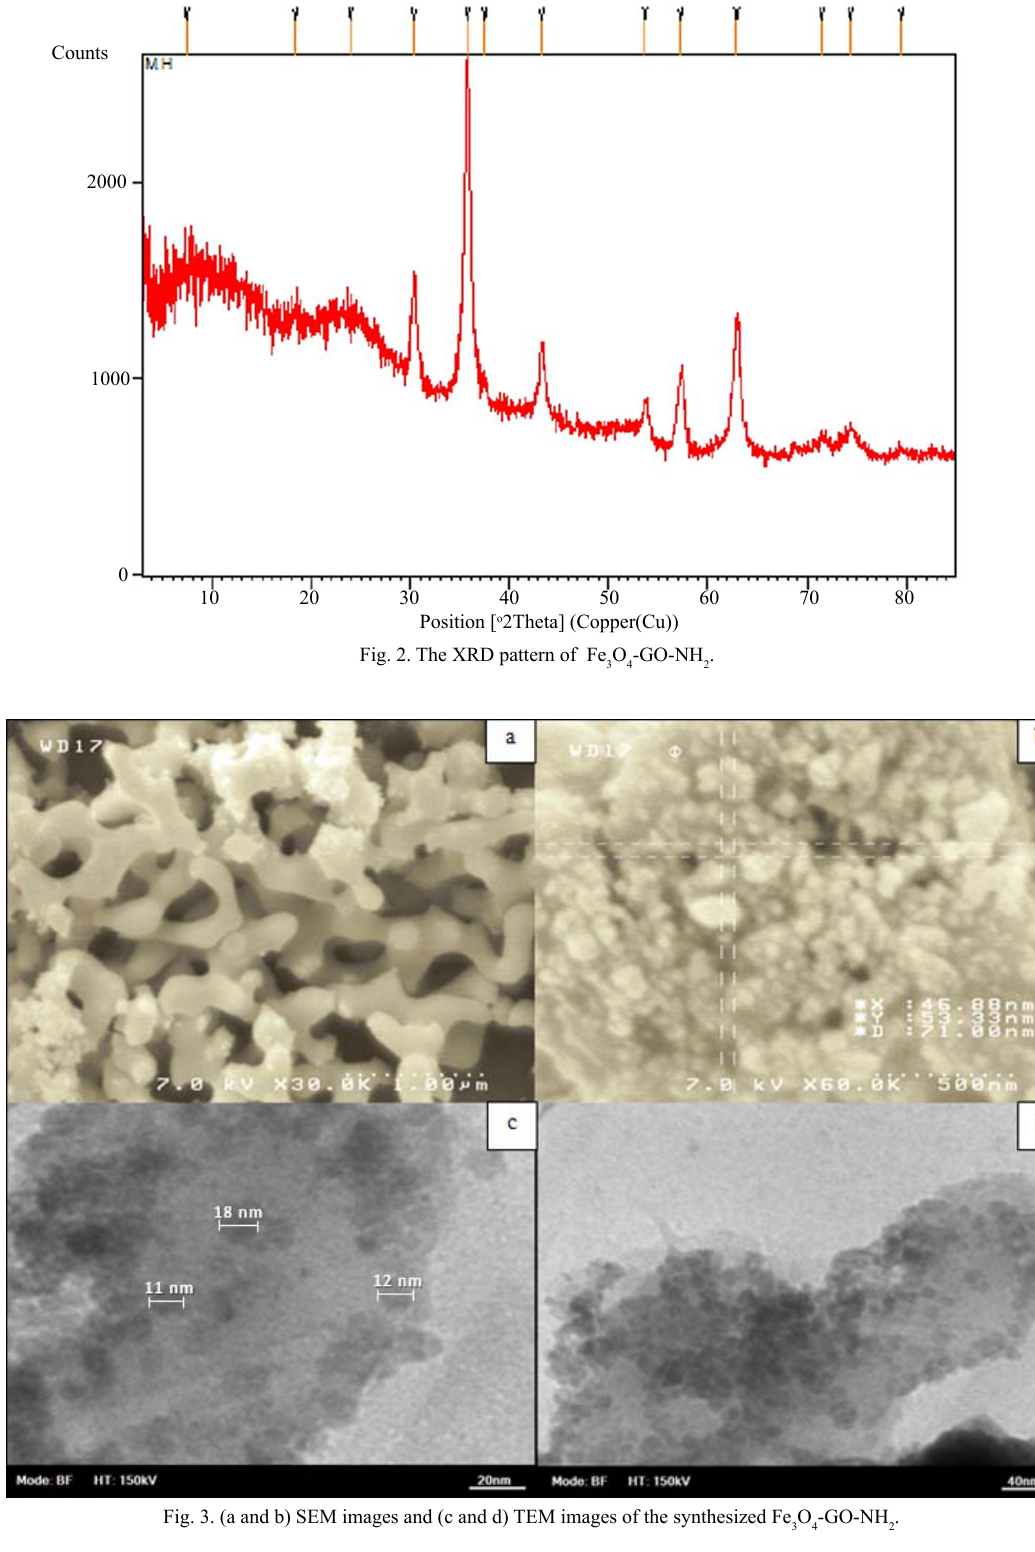
Fig. 3. (a and b) SEM images and (c and d) TEM images of the synthesized Fe